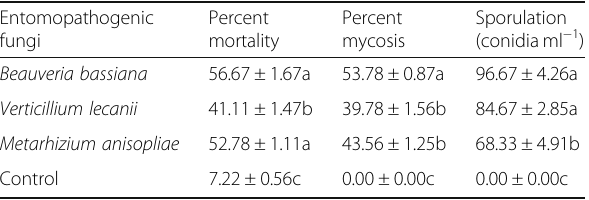
Table 2 Percentage mortality of the third instar of Cnaphalocrosis medinalis larvae and percentage of mycosis and sporulation from their cadavers assayed with the entomopathogenic fungi, Beauvaria bessiana , Verticelium lecanii, and Metarhizium anisopliae in a